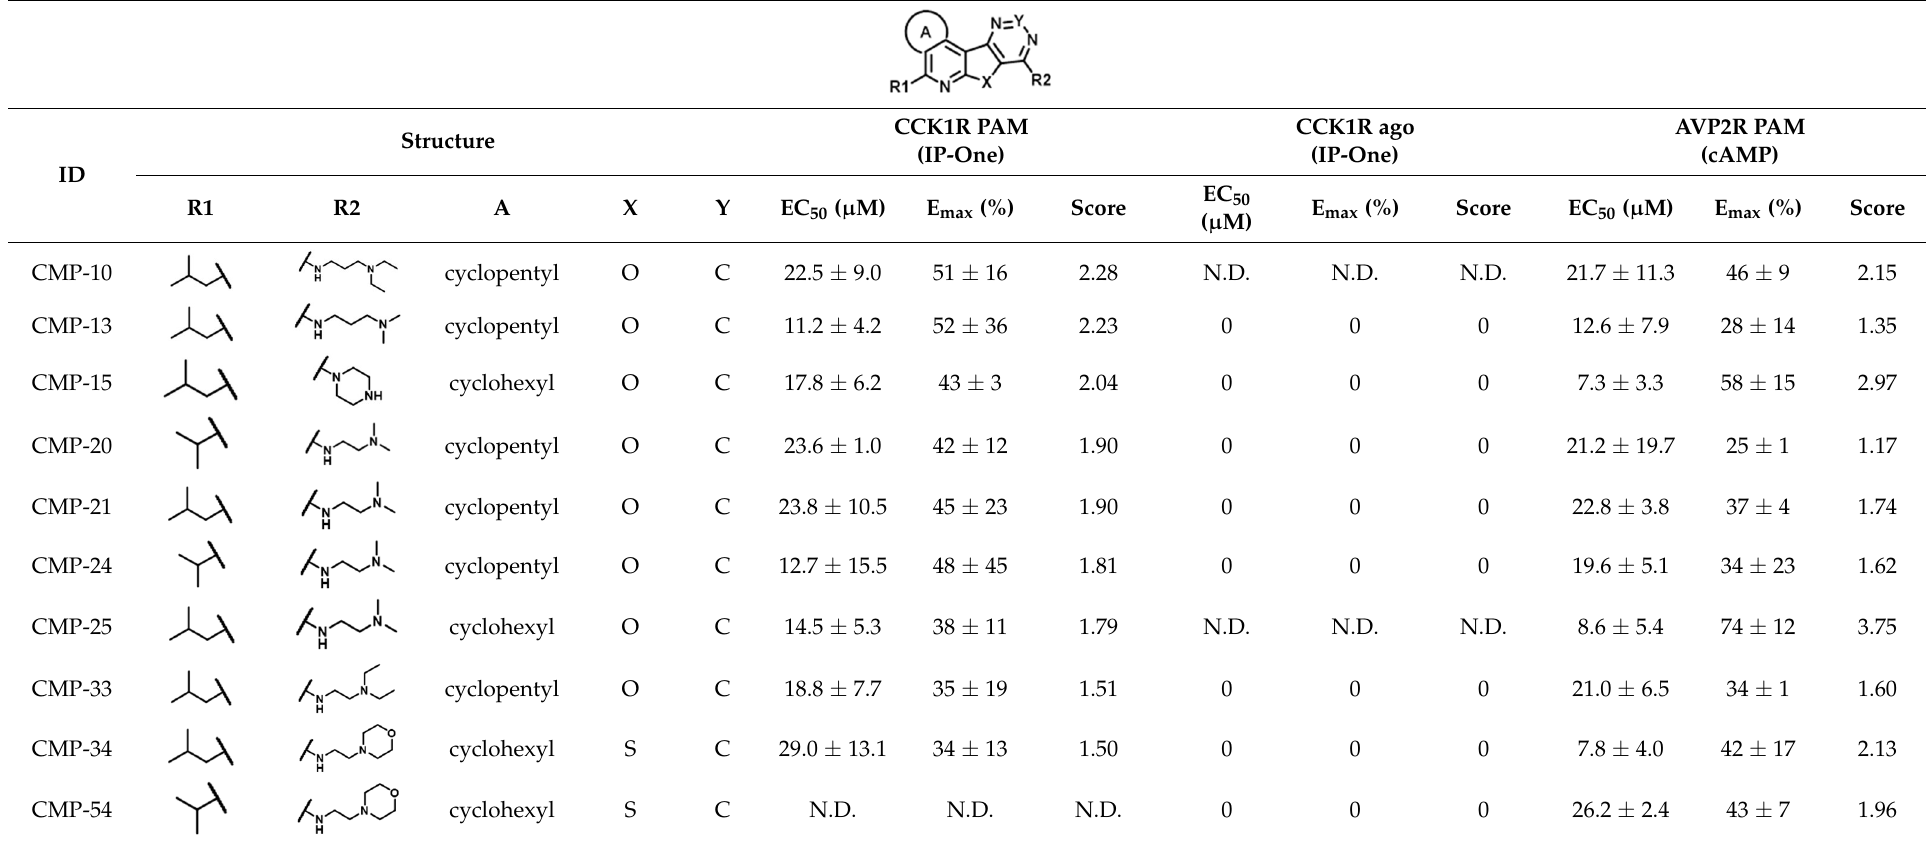
Table 7. Structure–activity studies of 10 branched alkyl analogs. SD), and calculated activity score (E max × pEC 50 ) of compound dose–response studies in screening mode. Compounds were tested in Cisbio IP-One and cAMP accumulation assays; N.D. = not deter- minable (response less than mean ± 3 × SD of negative control).